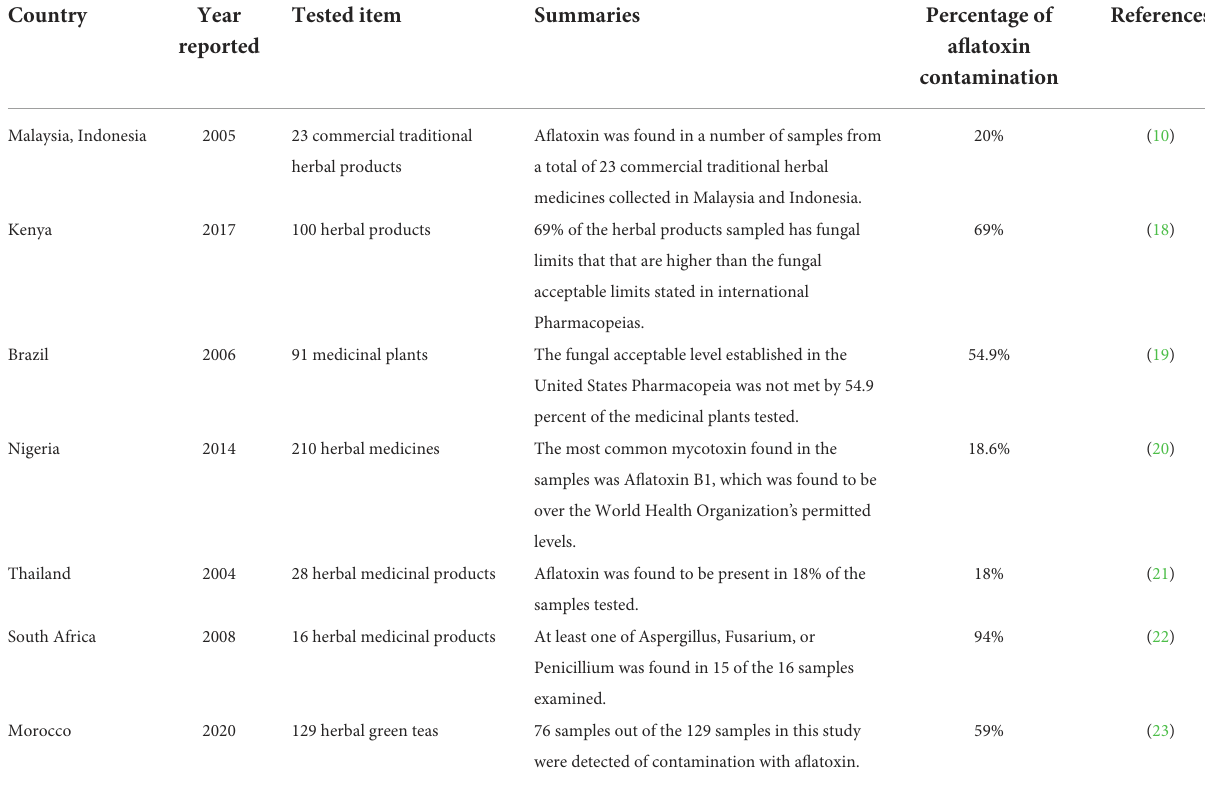
TABLE 1 Reported contamination of aflatoxin in herbal products at various